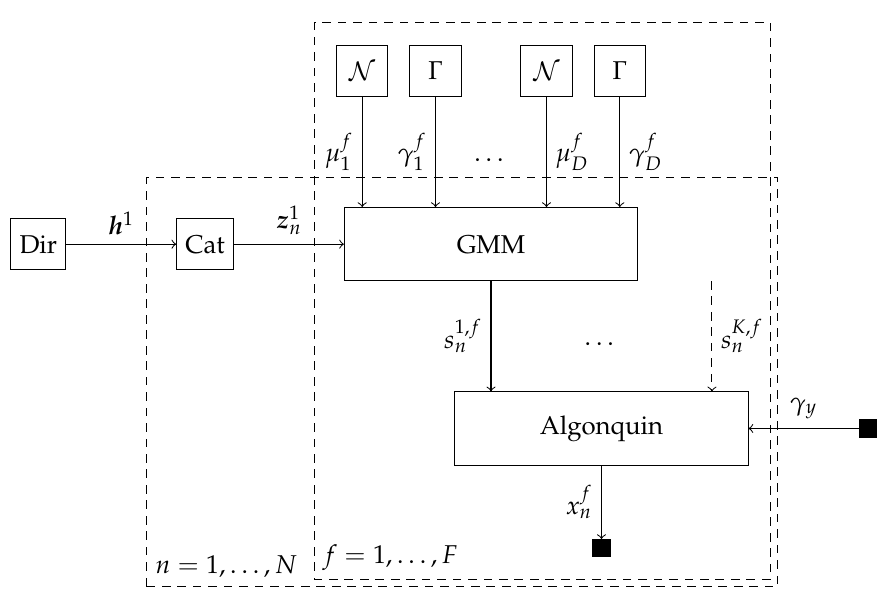
Figure 5. The Forney-style factor graph representation of the Algonquin-based generative model fully specified by (8), (12)–(16). The GMM composite node represents the Gaussian mixture node as specified in ([37], A.2). The Algonquin composite node has been summarized in Table 1. The dashed rectangular bounding boxes here denote plates, which represent repeating parts of the graph. Edges that are intersected by the plate boundaries are implicitly connected between plates using equality nodes.